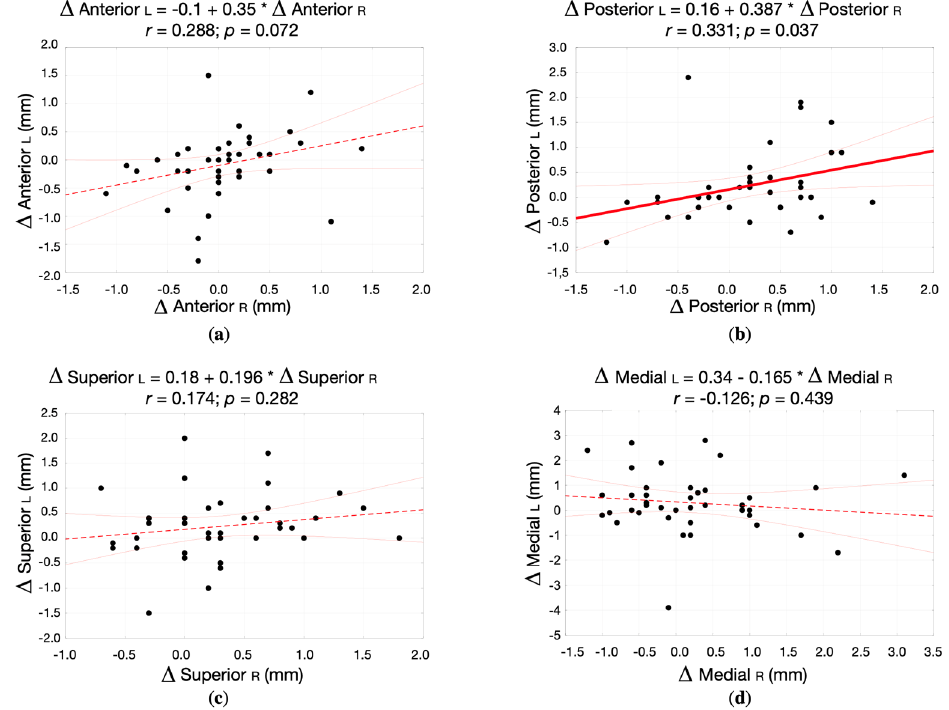
Figure 7. The correlation between the changes in the dimension of different joint spaces within right and left TMJs (correlation diagrams, correlation coefficient, and regression straight line equation) in the study group: ( a ) Anterior joint space; ( b ) Posterior joint space; ( c ) Superior joint space; ( d ) Medial joint space.